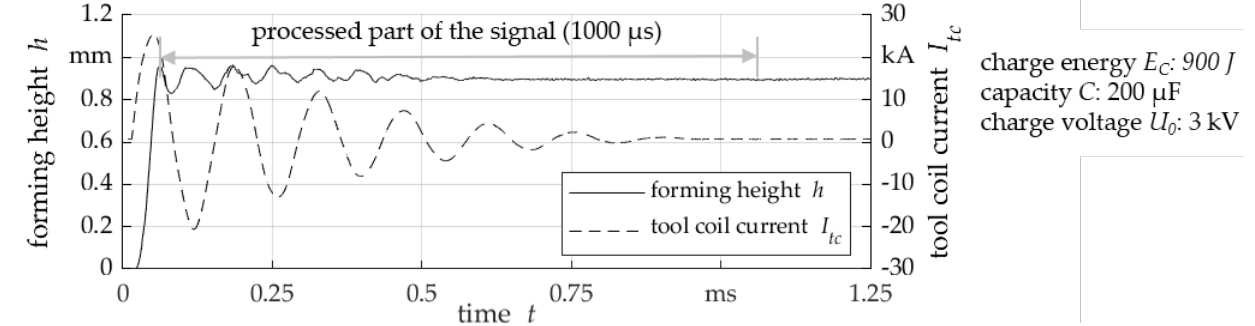
Figure 3. Definition of the processed interval of the forming height h signal and the measured tool coil current I tc.